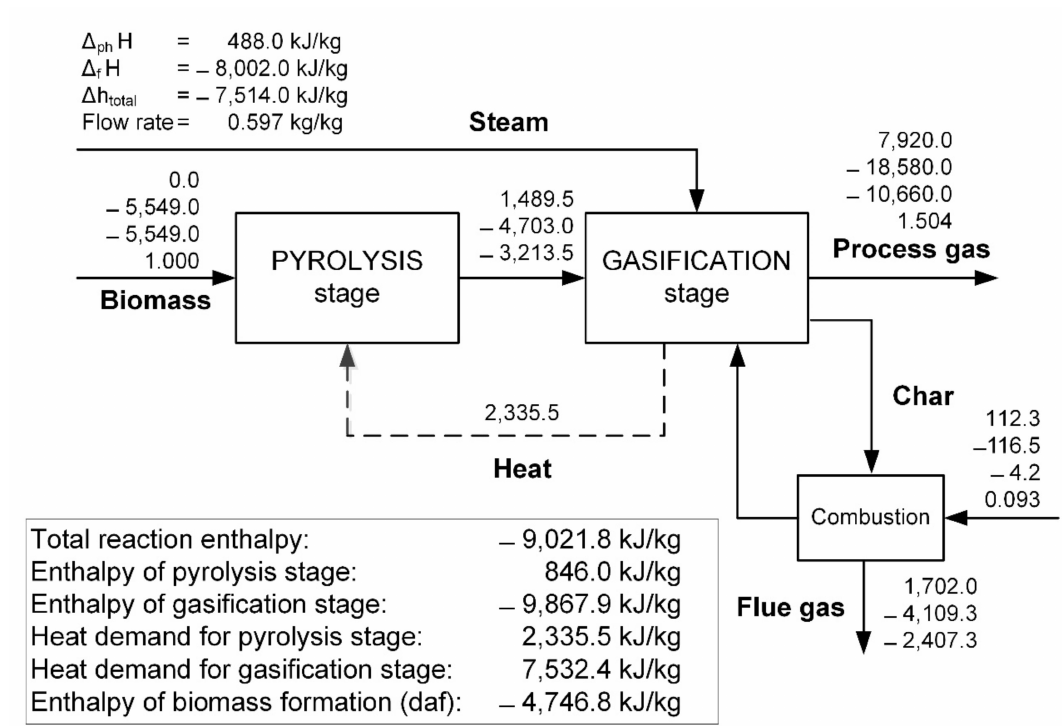
Figure 16. Energy balance of dual fluidized bed (DFB) process for sub-bituminous coal gasification per 1 kg of feed